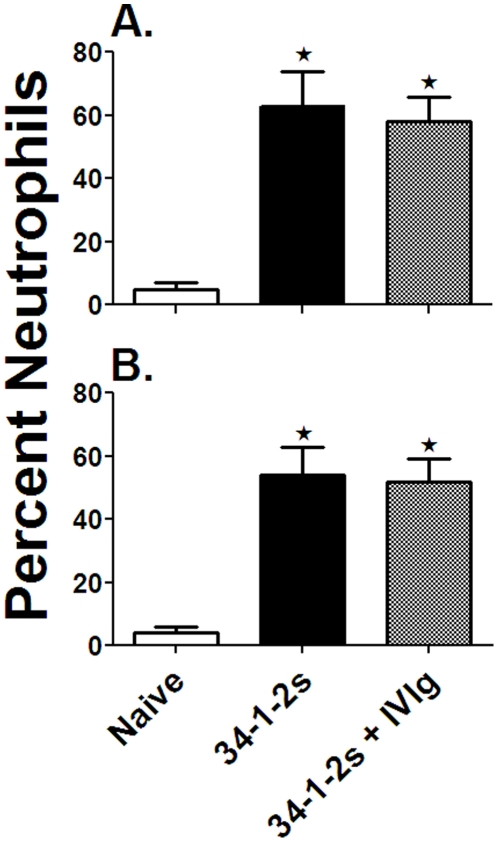
IVIg does not prevent 34-1-2s-induced pulmonary neutrophil accumulation in BALB/c or SCID mice.Percentage of neutrophils in cytospin samples of lungs from A) BALB/c mice or B) SCID mice. Mice were either non-treated (Naïve), 34-1-2s-treated (9 mg/kg for BALB/c mice and 2 mg/kg for SCID mice) or 34-1-2s and 2 g/kg IVIg treated. Neutrophils were enumerated on cytospin slides using ImageJ software. The data are expressed as percent neutrophils in total nucleated cells. The ★ indicates significance (p<0.05) between naïve mice and the other groups of mice Determined by Student's t test.